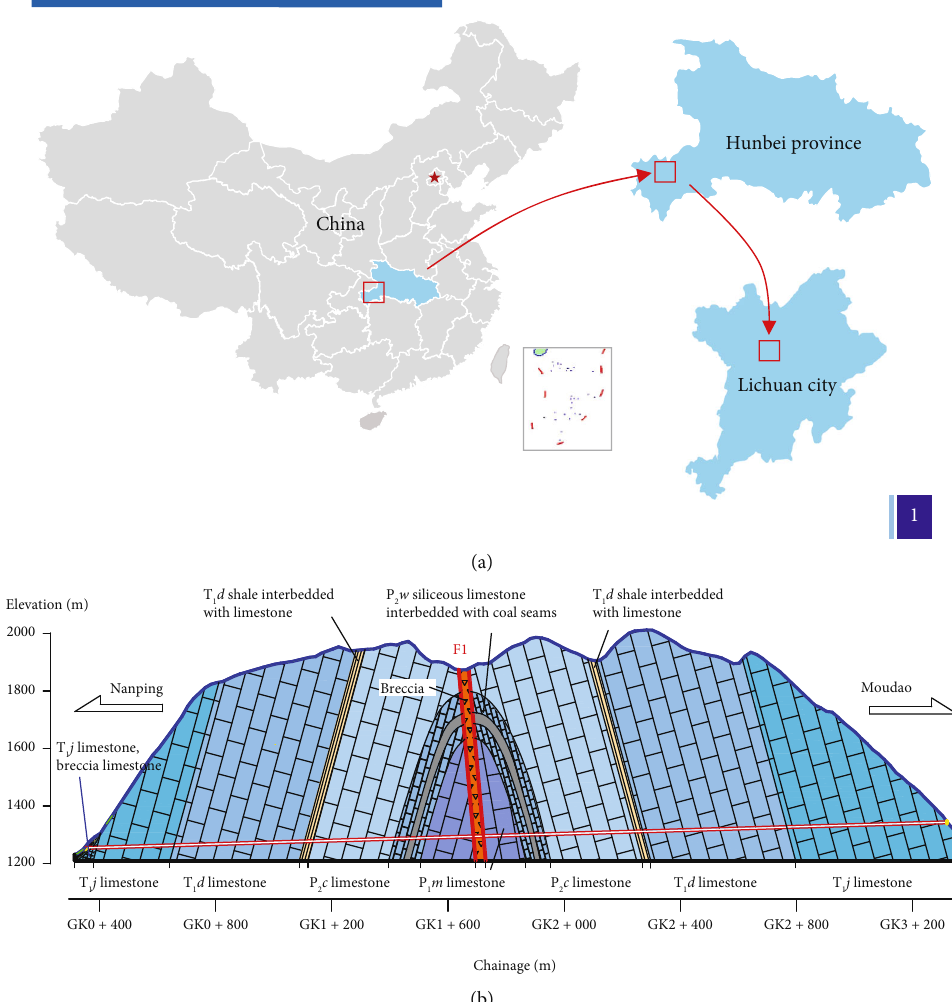
Figure 1: Location and geology maps of the study area. (a) Location of the study area; (b) longitudinal geological pro fi les of the Qiyueshan Tunnel